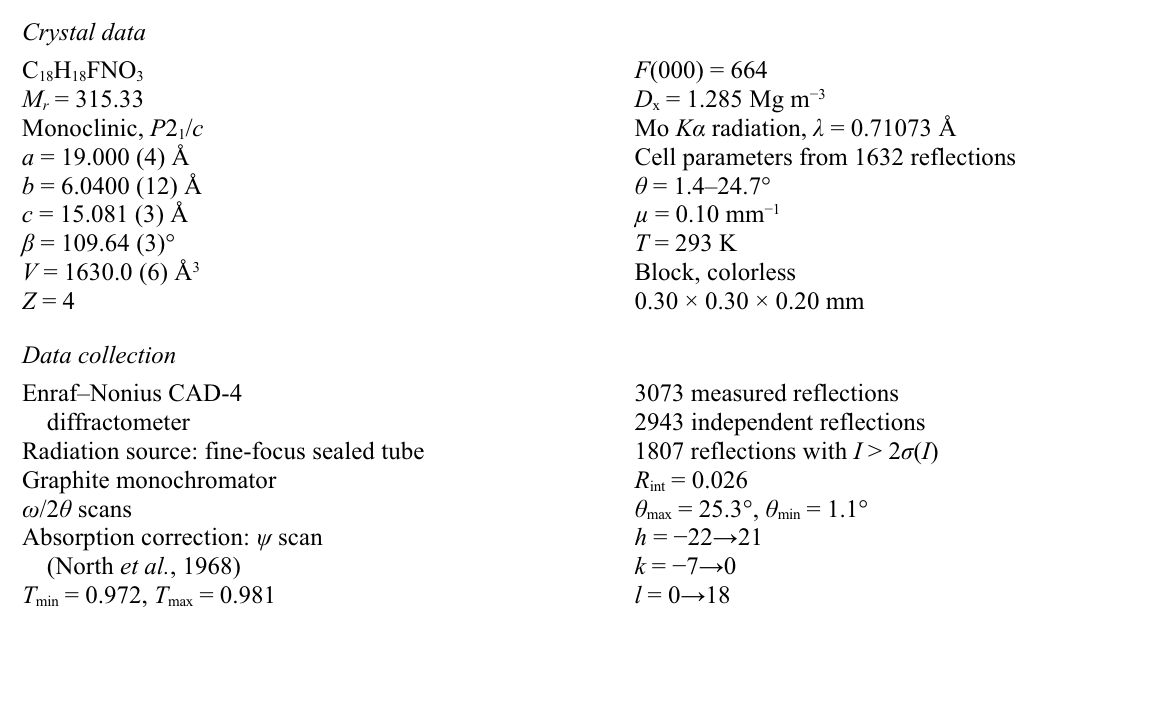
The crystal packing of the title compound, showing the linking of the hydrogen bonded ribbons by C—H··· π interactions. Dashed lines indicate C—H···O, N—H···O and C-H··· π interactions. ( E )-Ethyl